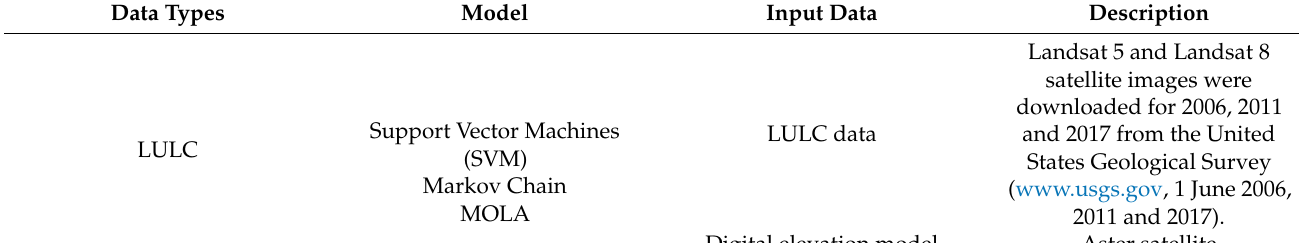
Table 1. The input data and sources for ES assessment and land use